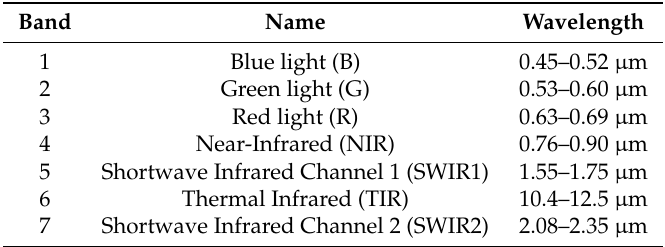
Table 1. Satellite frequency